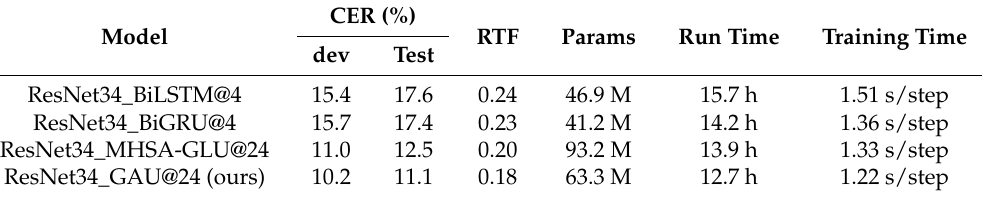
Table 3. Evaluation metrics of different